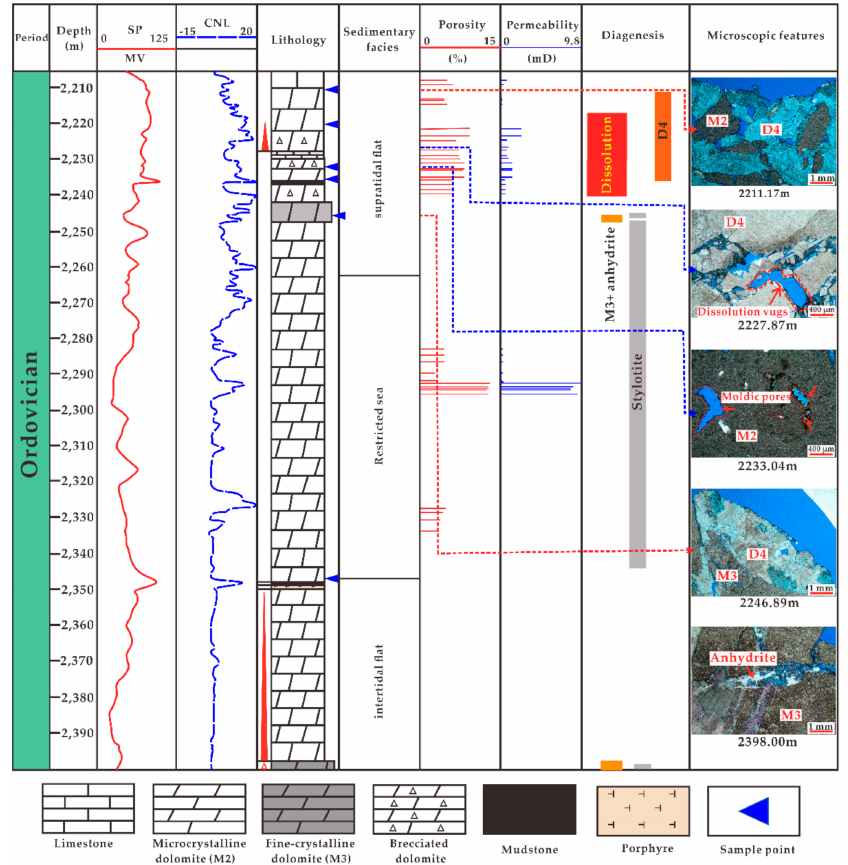
Figure 14. The stratigraphic log of well Bg22 and differences of diagenesis in different strata. M1: argillaceous dolomite; M2: microcrystalline dolomite; M3: fine-crystalline dolomite; D4: saddle